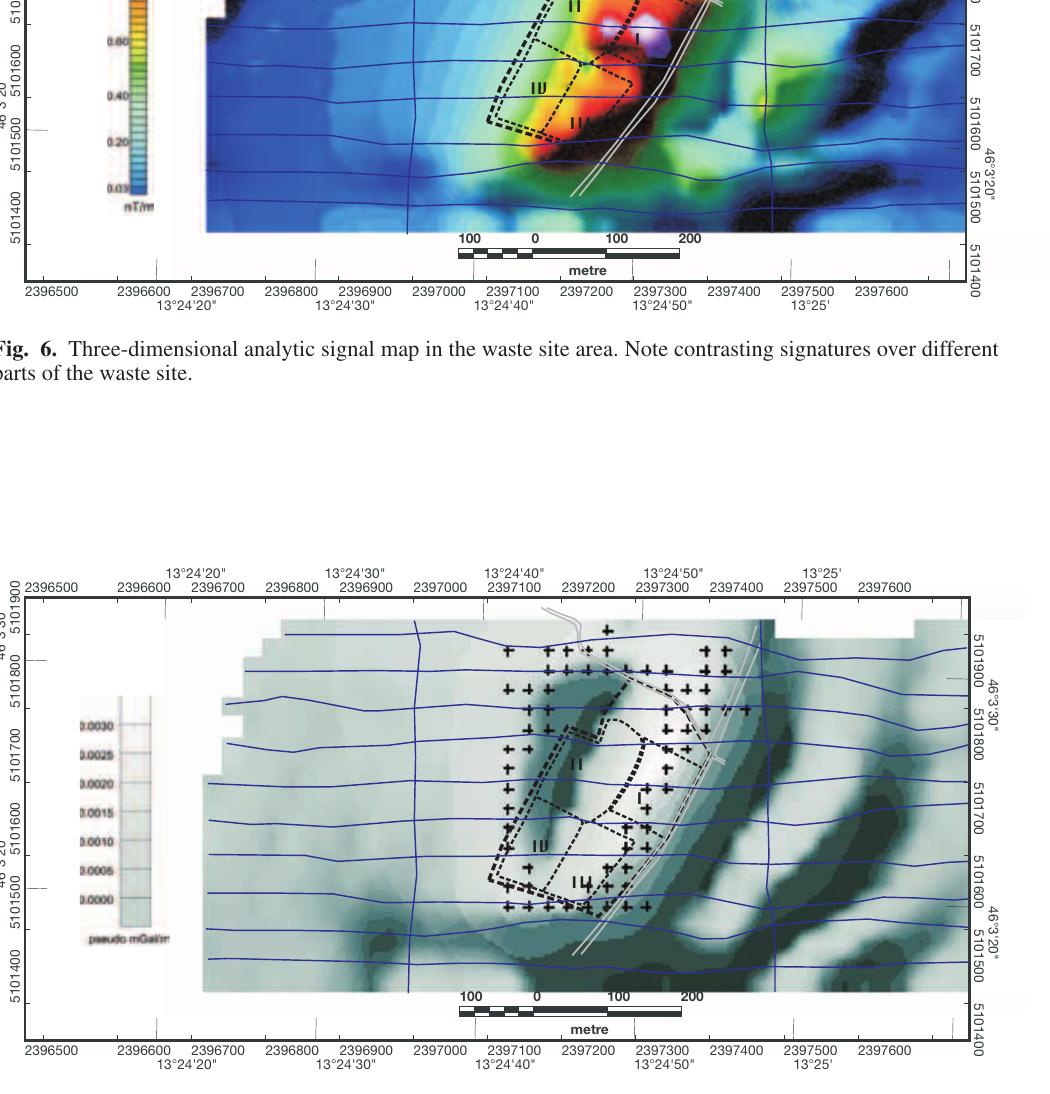
Fig. 7. Maximum horizontal gradient of pseudo gravity over the waste site area with local peaks indicated with black crosses. Note relative peak over the saturated part of the waste site